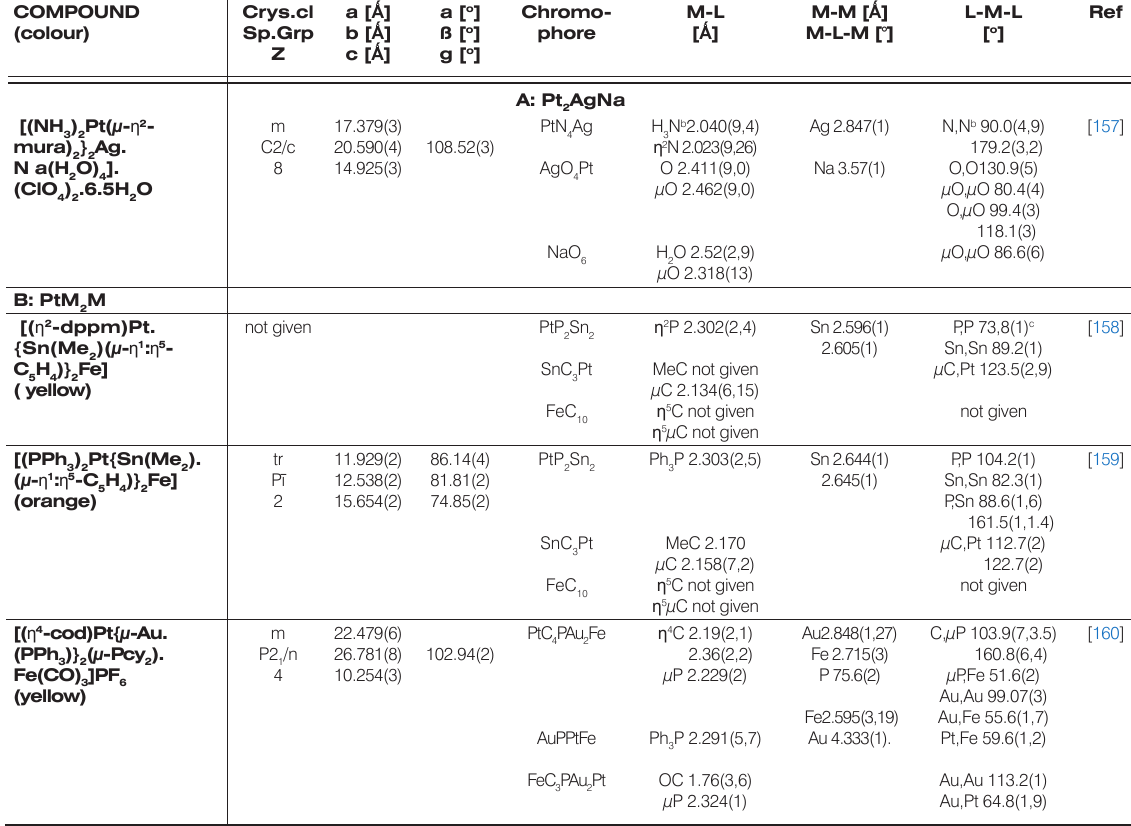
RuPt(µ-CC 2 Crys.cl